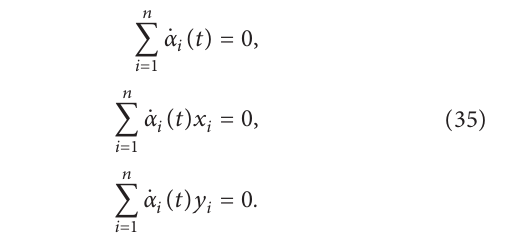
Figure 4: Level set function reinitialization.